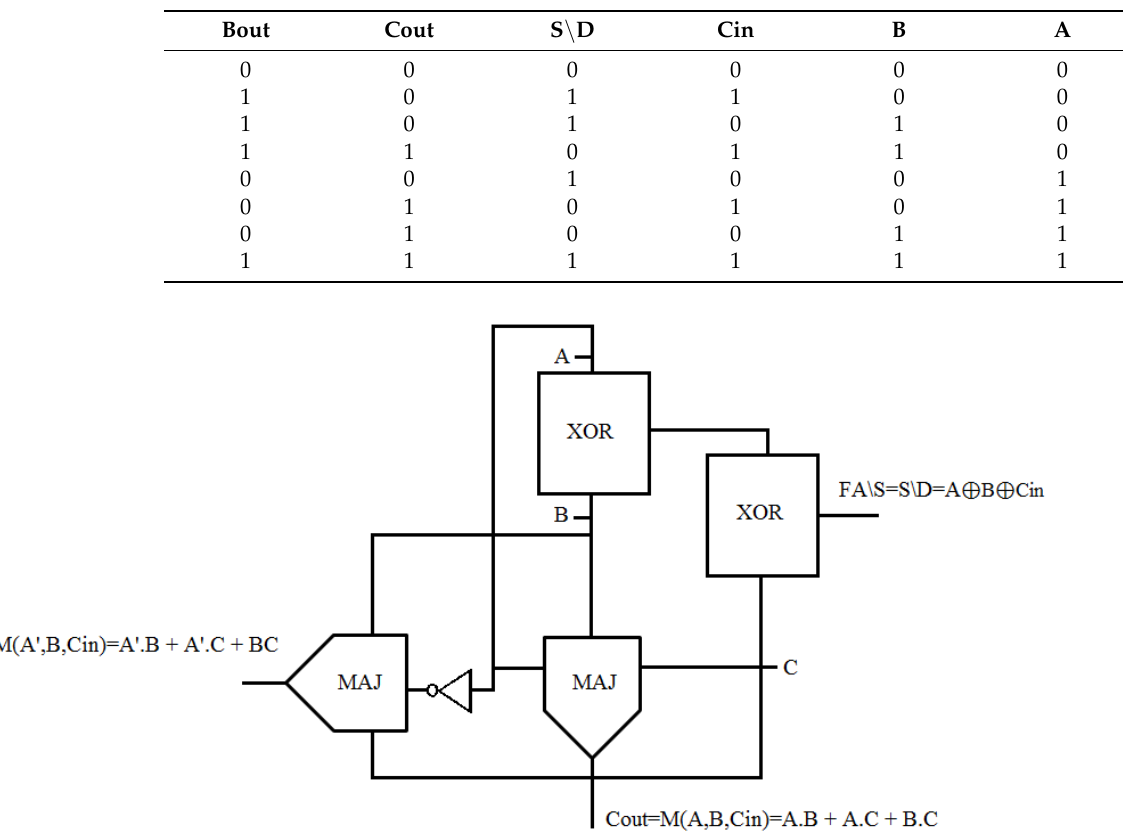
Figure 13. Simulation results of the proposed XOR-gate.